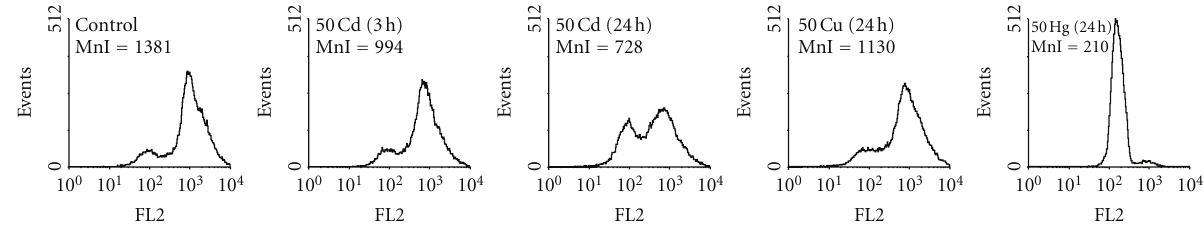
Figure 3: E ff ects of Cd 2+ , Cu 2+ , and Hg 2+ on mitochondrial membrane potential of PC12 cells monitored by flow cytometry after staining the cells with the lipophilic cationic probe TMRM. MnI—mean intensity of fluorescence (arbitrary units) is indicated in the upper left corner of each panel. A typical experiment out of at least three independent ones for each metal is shown. For other details, see Section 2.